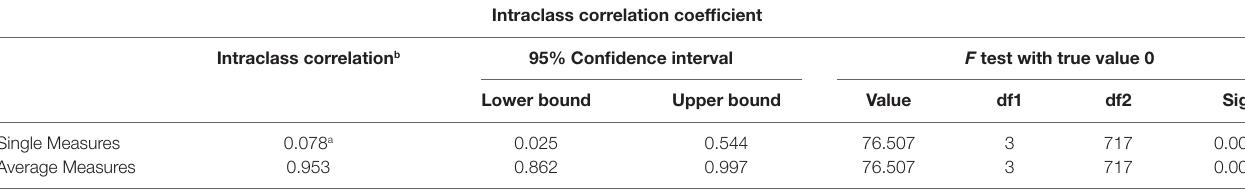
TaBle a2 | Intraclass Correlation Coefficient (ICC) of the four judges on